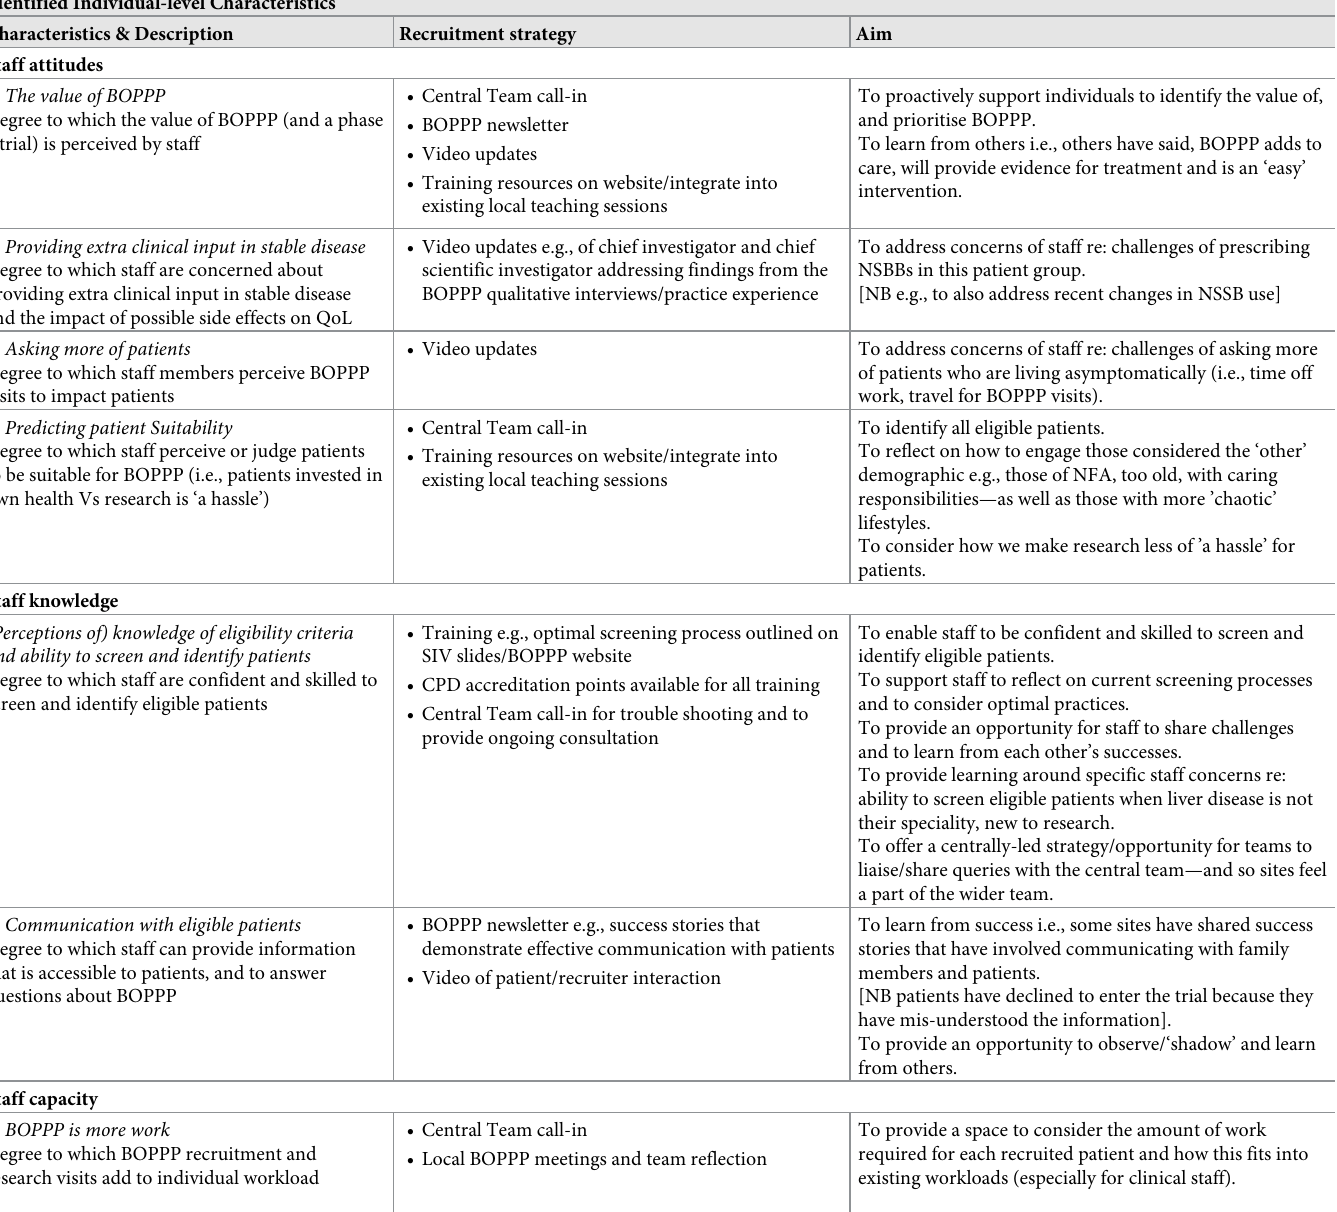
Table 5. Themes and corresponding recruitment